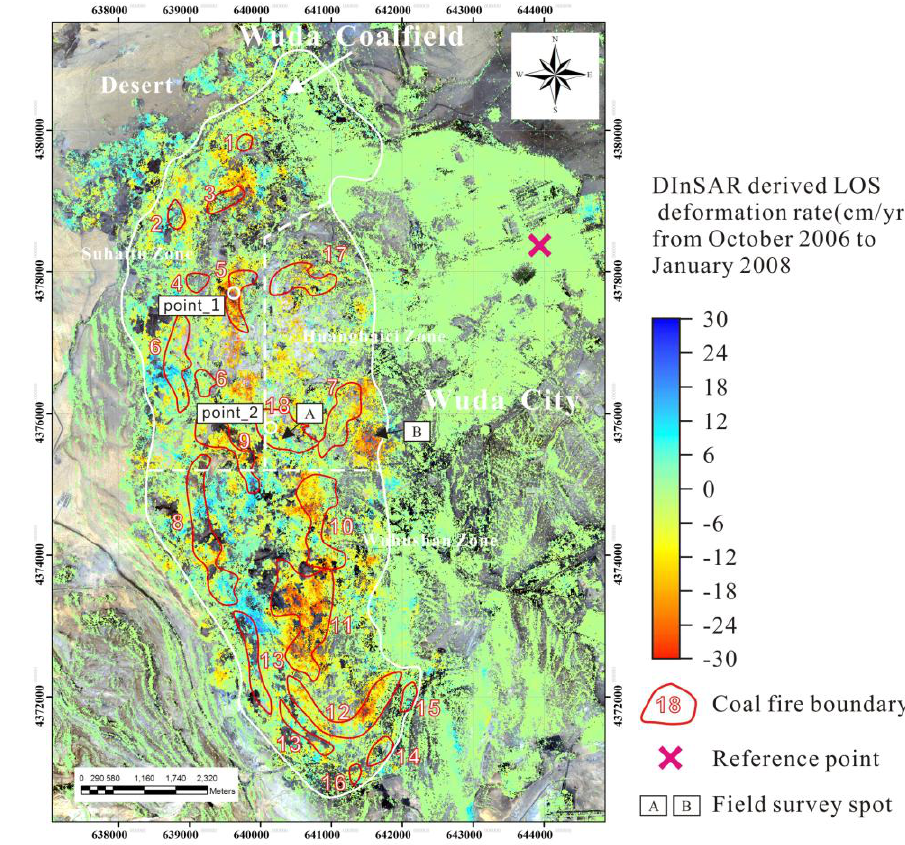
Figure 6. DInSAR derived subsidence rate map in Wuda coalfield from October 2006 to January 2008. The colour tones from light yellow to red correspond to subsiding areas; the tones from dark blue to sky blue indicates slight uplift; the light green correspond to stable areas. This result is superimposed on a Google Earth image and the magenta cross represents the location of the reference point, which is loated in Wuda urban area. The red polygons illustrate the coal fire boundaries mapped in the field survey in 2008 and the rectangles labeled A and B indicate field survey spots.